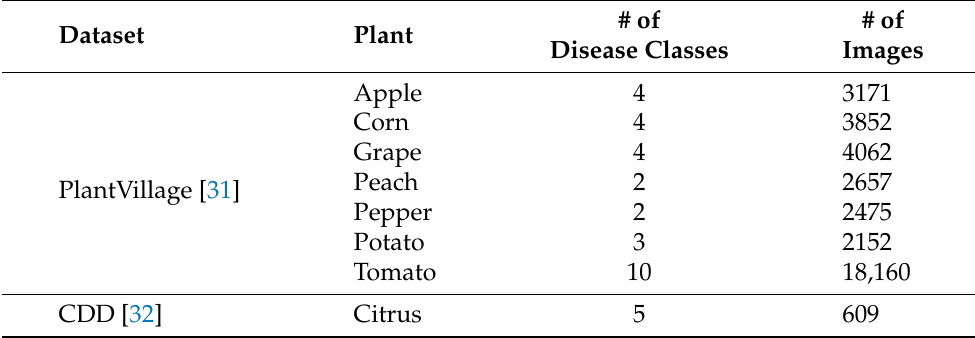
Figure 5. Some leaf images from the PlantVillage dataset. The name of the leaves and the diseases are given for each leaf. The visual features of diseased images are mostly similar, which makes the decision process challenging. Table 2. Quantitative analysis of the